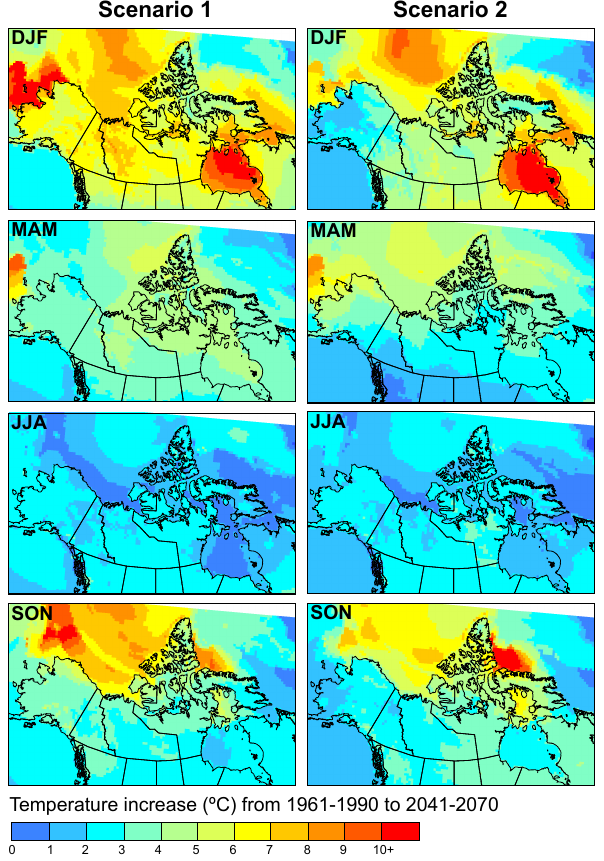
Fig. 9a. Increase in air temperature from 1961–1990 mean to 2041– 2070 mean from the CRCM data displayed by season Winter